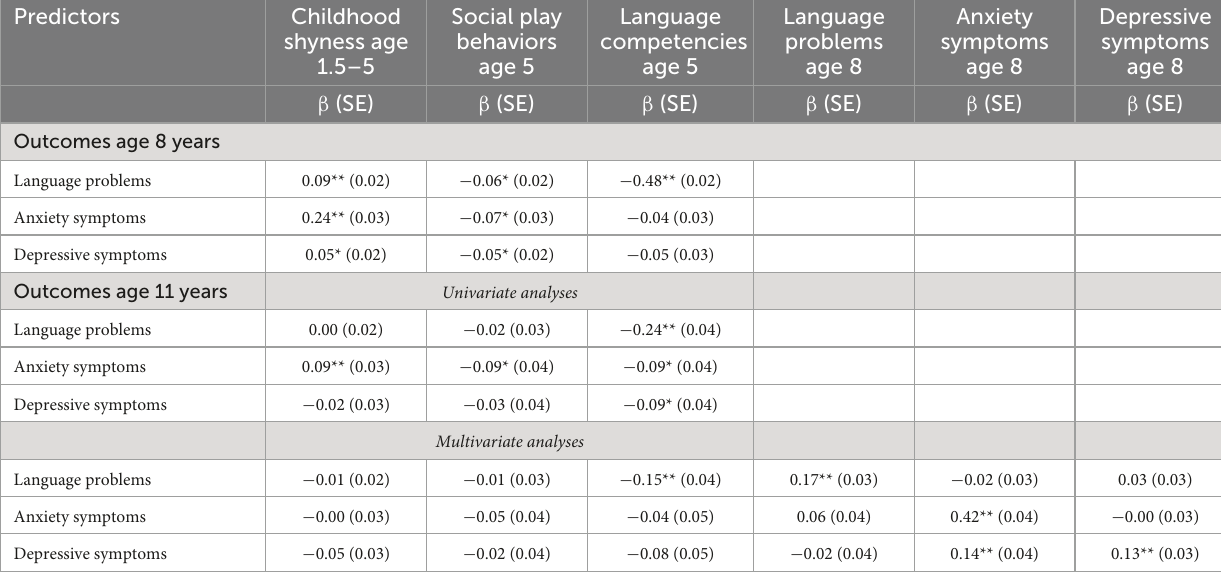
TABLE 2 Results from univariate and multivariate regression analysis with childhood shyness and social play behaviors and language competencies at age 5 years as predictors of internalizing and language problems at age 8 and 11 years.